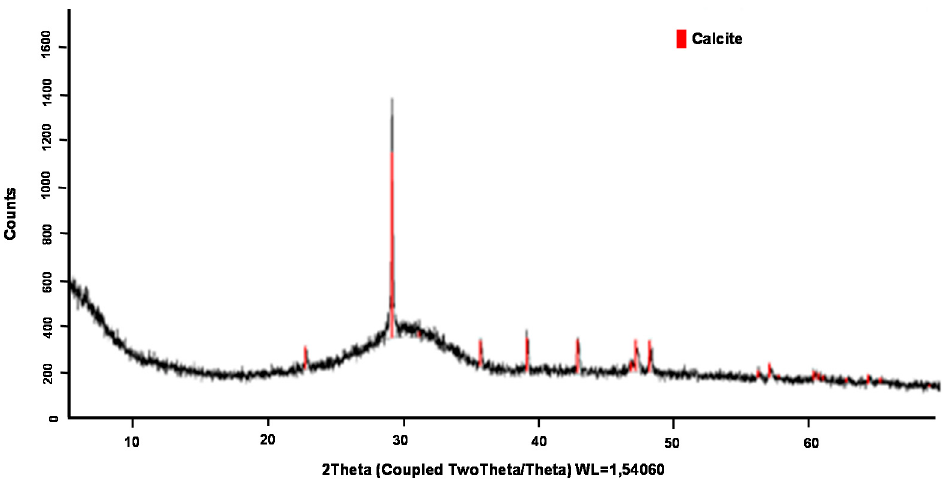
Figure 11. X-ray diffraction of BFS.